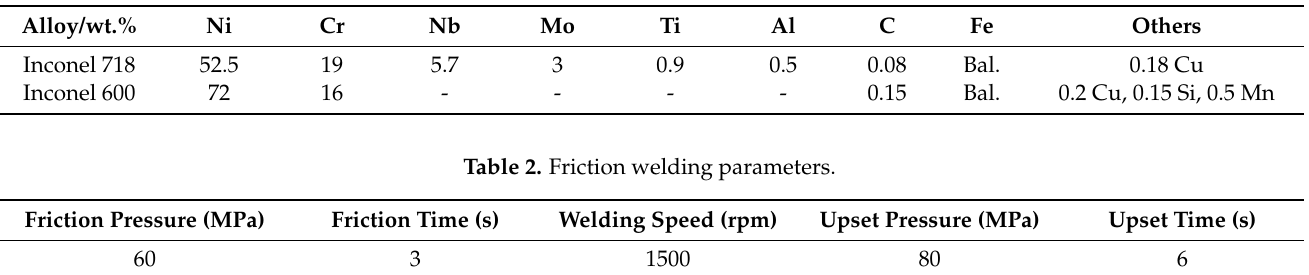
Table 1. Chemical composition of the Inconel 718 and Inconel 600.